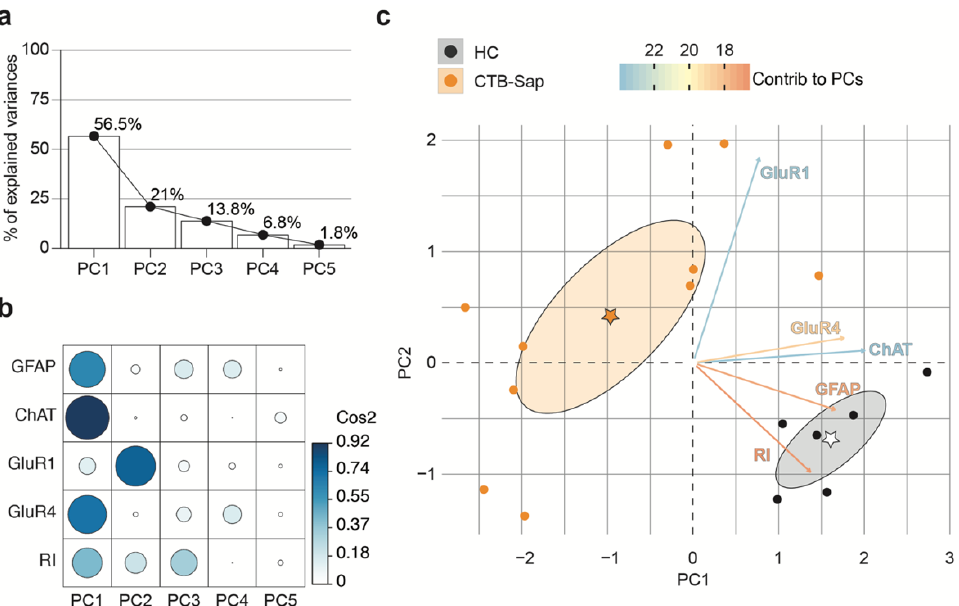
Figure 6. The association between behavioral and molecular outcomes at 7 dpl assessed by principal components analysis (PCA). ( a , b ) Scree plot of PCs (PC1–PC5) and the percentage of GluR1, GluR4, ChAT, and GFAP, and the recovery index (RI) explained variance ( a ) and quality of representation of the variables on the factor map expressed as square cosine (Cos2); ( c ) PCA biplot of GluR1, GluR4, ChAT, GFAP, and RI data for n = 10 CTB-Sap lesioned mice and n = 6 HC mice; key colored arrows represent the variables’ contribution to the PC; stars indicate the mean points of groups, and confidence ellipses are also shown.